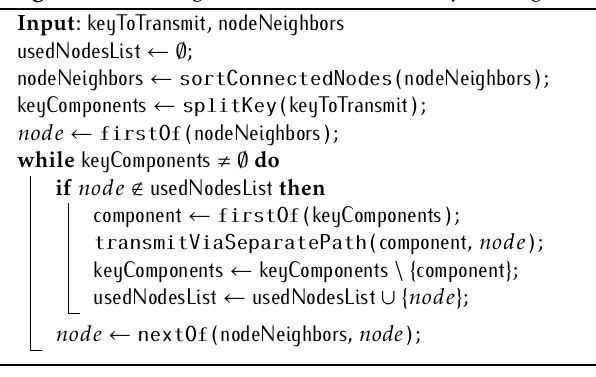
Algorithm 1: Neighbor selection and subkey